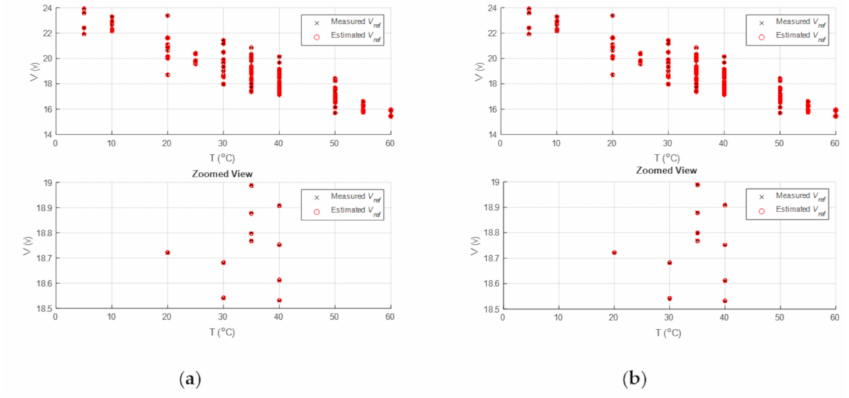
Figure 8. Predicted and measured V ref for di ff erent temperature values using: ( a ) SVR; ( b ) GRNN.